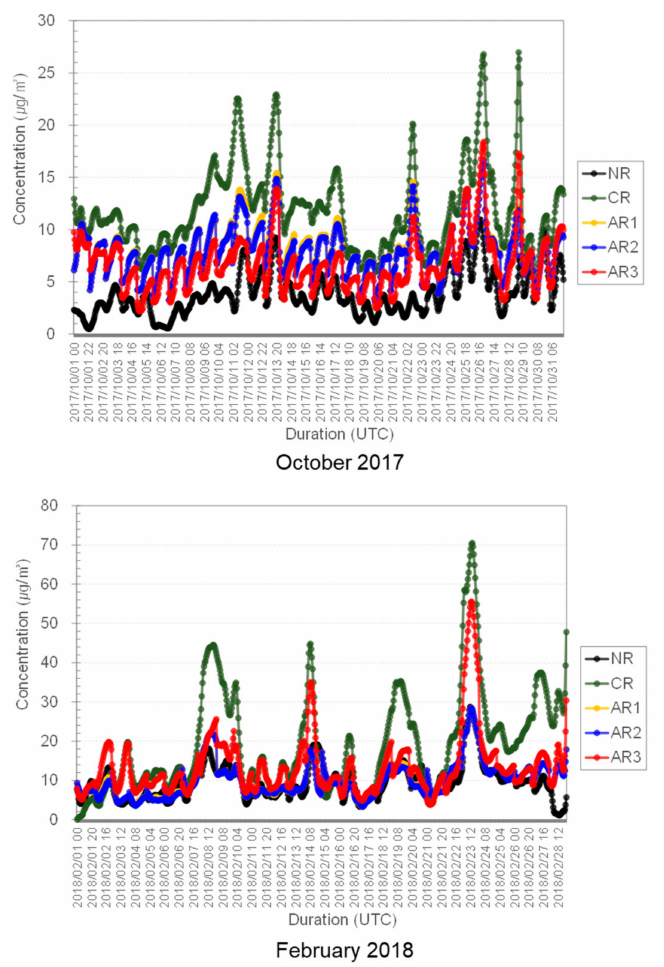
Figure 8. The time series of the simulated results for PM 2.5 of NR, CR, and Ars at 208 monitoring sites in South Korea in October 2017 and February